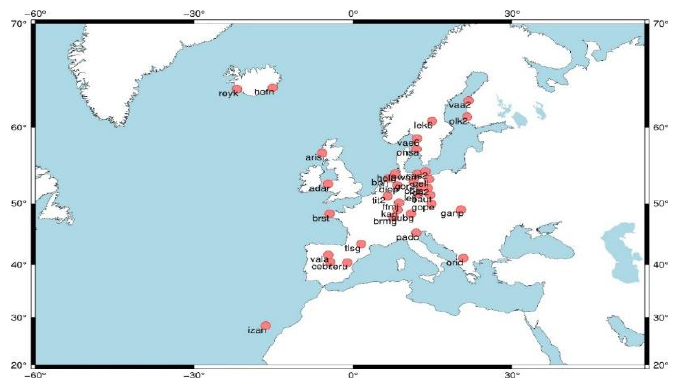
Figure 8. Distribution of float posteriori NL ambiguity residual errors (2021, day 185) as ( a ) posteri- ori residual errors when estimating NL FCB with traditional method; ( b ) posteriori residual errors when estimating NL FCB with proposed method.